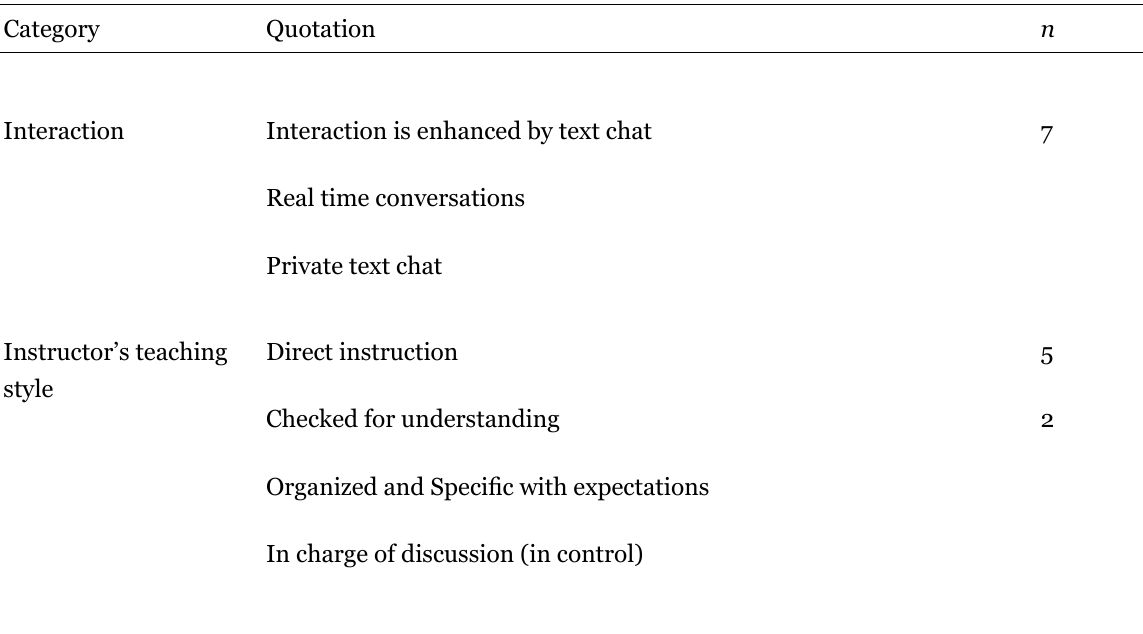
Student Responses to Learner-Instructor